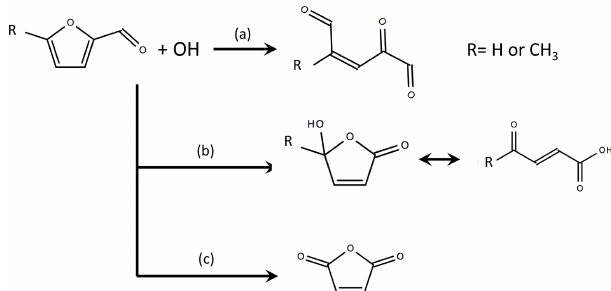
Figure 6. Summary of OH oxidation pathways and final prod- ucts for furfural and 5-methylfurfural, where branch (a) is the substituent-retention pathway, and branches (b) and (c) are substituent-loss pathways (adapted from Zhao and Wang, 2017). The branching ratios estimated by Zhao and Wang (2017) are 0.37 for channel (a) , 0.6 for channel (b) , and 0.03 for channel (c) . Details of the assumed RO 2 reaction schemes are provided in Figs.